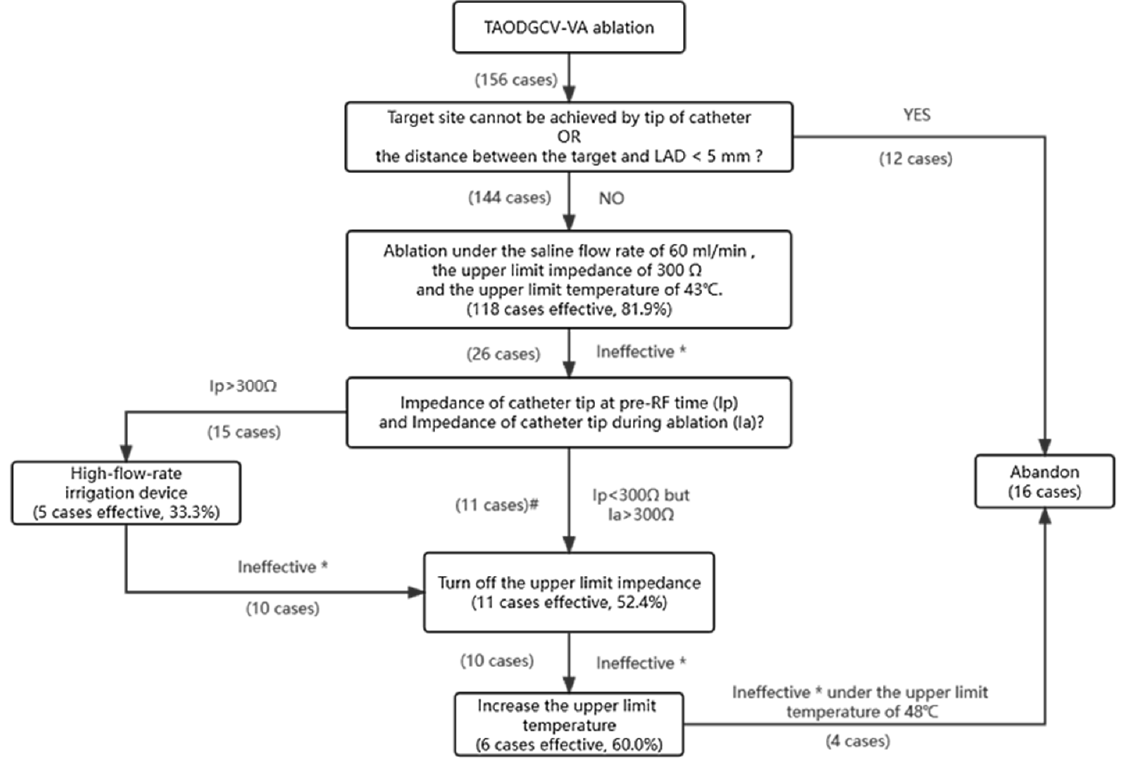
Figure 4. The ablation process of patients with TAODGCV-VA. TAODGCV-VA = =ventricular arrhythmia originating from the transitional area of the distal great cardiac vein; LAD = left anterior descending coronary artery. * Ineffective means does not meet the standard of effective ablation (VA is terminated and cannot be induced by intravenous administration of isoproterenol and programmed stimulation, which usually requires energy delivery >20 W and lasting >30 s). # Ineffective because the spontaneous cut-off caused by the sharp impedance increase during